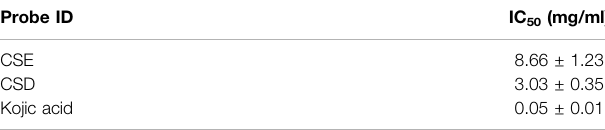
TABLE 3 | Enzyme inhibitory effects of the extracts of CSE and CSD (values expressed are mean ± S.D. of three parallel measurements, p < 0.05). Probe ID